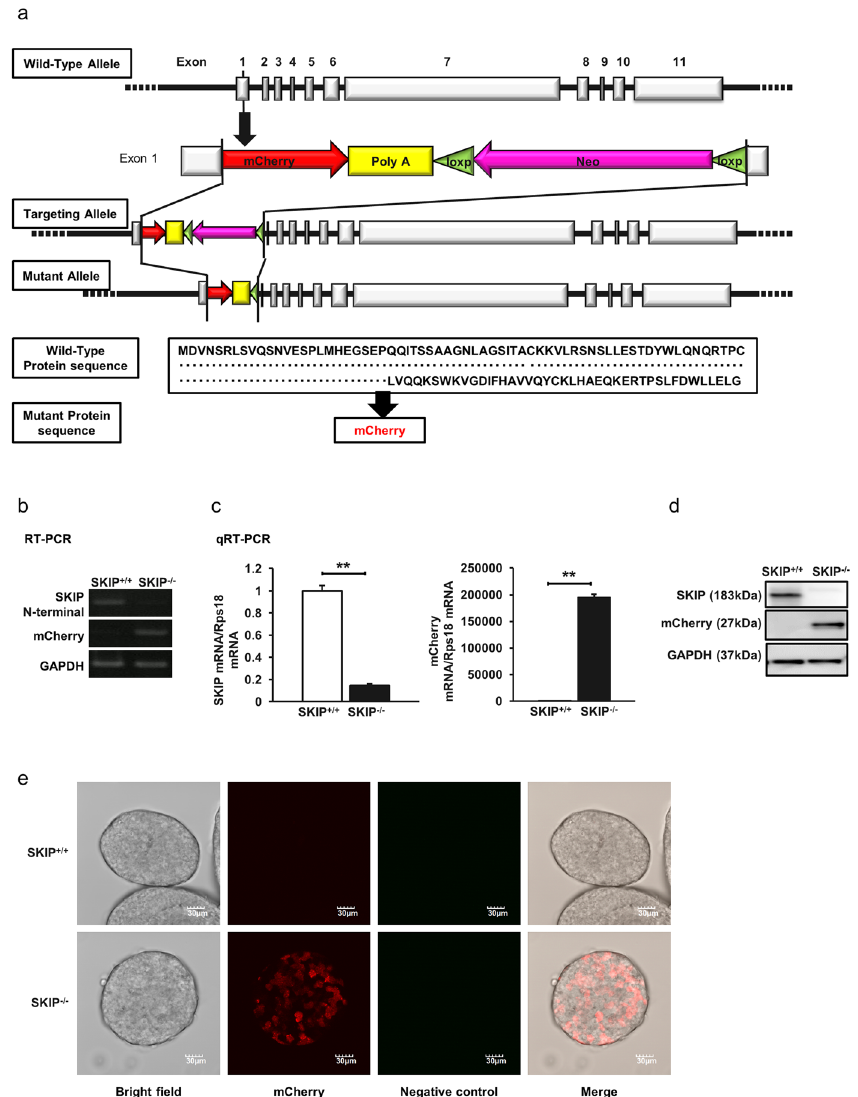
Figure 2. Generation of SKIP-mCherry knock-in (KI) mice. ( a ) Construct of SKIP-mCherry KI mice. mCherry-poly(A)-loxp-Neo-loxp was inserted into exon 1 of wild-type SKIP gene, and later, loxp-Neo was deleted to generate the mutant allele. In the mutant protein sequence, SKIP expression was deleted by mCherry expression. mRNA expression of SKIP and mCherry in isolated islets from homo SKIP-mCherry KI (SKIP − / − ) mice and wild type (SKIP + / + ) mice detected by RT-PCR ( b ) and qRT-PCR ( c ); data are expressed as average ± standard error of the mean (SEM). ** p < 0.005 SKIP − / − vs SKIP + / + , significance was determined by student’s t-test ( c ). ( d ) Protein expression of SKIP in isolated islets from SKIP − / − mice and SKIP + / + mice detected by western blot with anti-mouse SKIP antibody. The membrane was reprobed with anti-mCherry antibody, and reprobed with anti-GAPDH antibody as control. All gels were run under the same experimental conditions. Uncropped images of blots/gels are shown in Supplementary Figure 5. ( e ) Expression of mCherry in isolated islets from SKIP − / − mice and SKIP + / + mice. Living islets were observed by incubator two-photon excitation microscopy. Two-photon excitation was effected at 1040 nm, the fluorescence of mCherry and negative controls were measured at 575–650 nm and at 460–495 nm, respectively. ( b – e ) n = 4–6 mice per group and 3 samples per group, 12-week-old mice were used for SKIP is specifically expressed in pancreatic β -cells. We examined SKIP localization in the islets to clar- ify the mechanism of SKIP-modified insulin secretion. Immunohistochemical analysis also showed that mCherry was detected only in β -cells, and not in α -cells from SKIP − / − mice (Fig. 3a). Three-D imaging by incubator two-photon microscopy revealed mCherry signals to be visible in isolated β -cells from SKIP − / − mice (Fig. 3b). Incubator two-photon excitation microscopy also showed the mCherry signal to be strongly detected in a single β -cell of SKIP − / − mice, but not in SKIP + / + mice, as displayed in a single β -cell of MIP-GFP mice 32, 33 (Fig. 3c). These finding indicate that SKIP is specifically expressed in pancreatic β -cells.